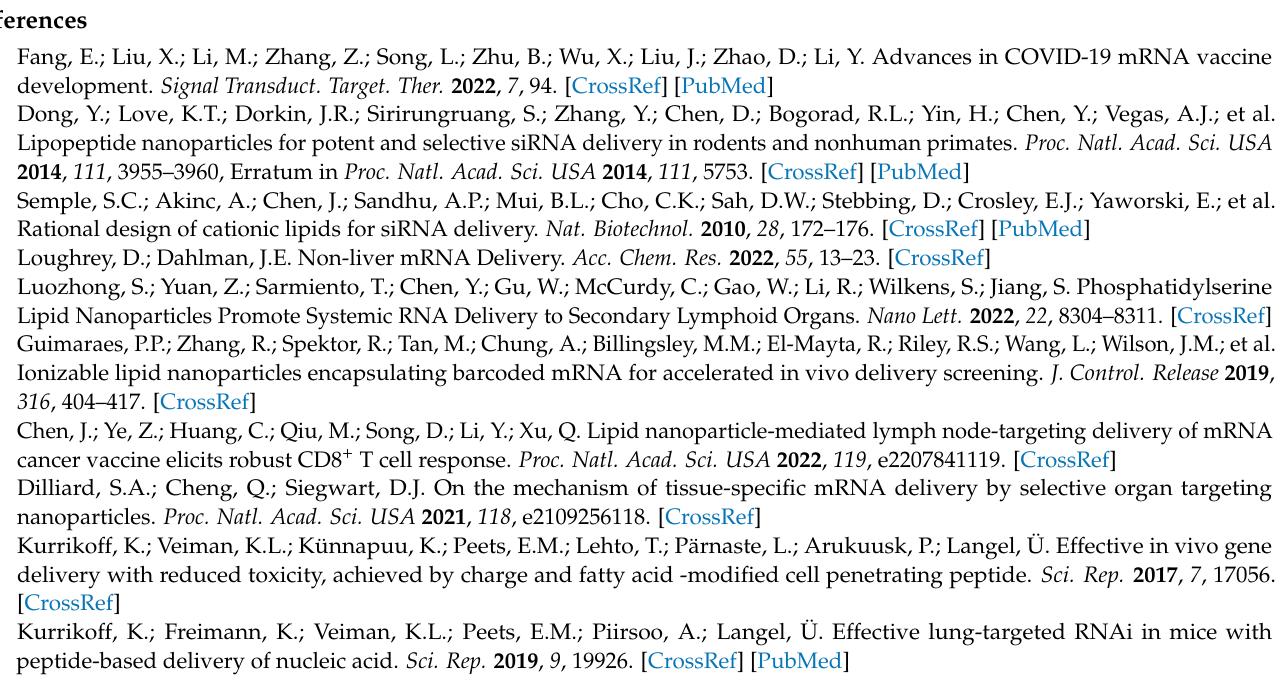
Figure S4: Gating strategy for sorting spleen cells. Figure S5: Assessment of CPP/NA complexes with gel migration assay. Figure S6: Helical wheel projections of new analogs compared to NF55. Figure S7: In vivo efficacy of NF55 new analogs for pDNA delivery. Statistics Section: Statistical analysis for